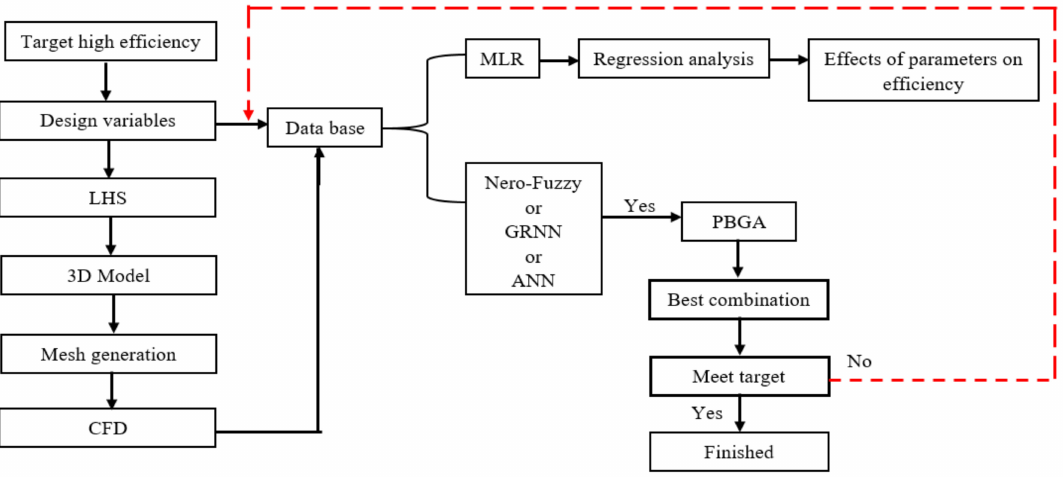
Figure 5. Optimization flow